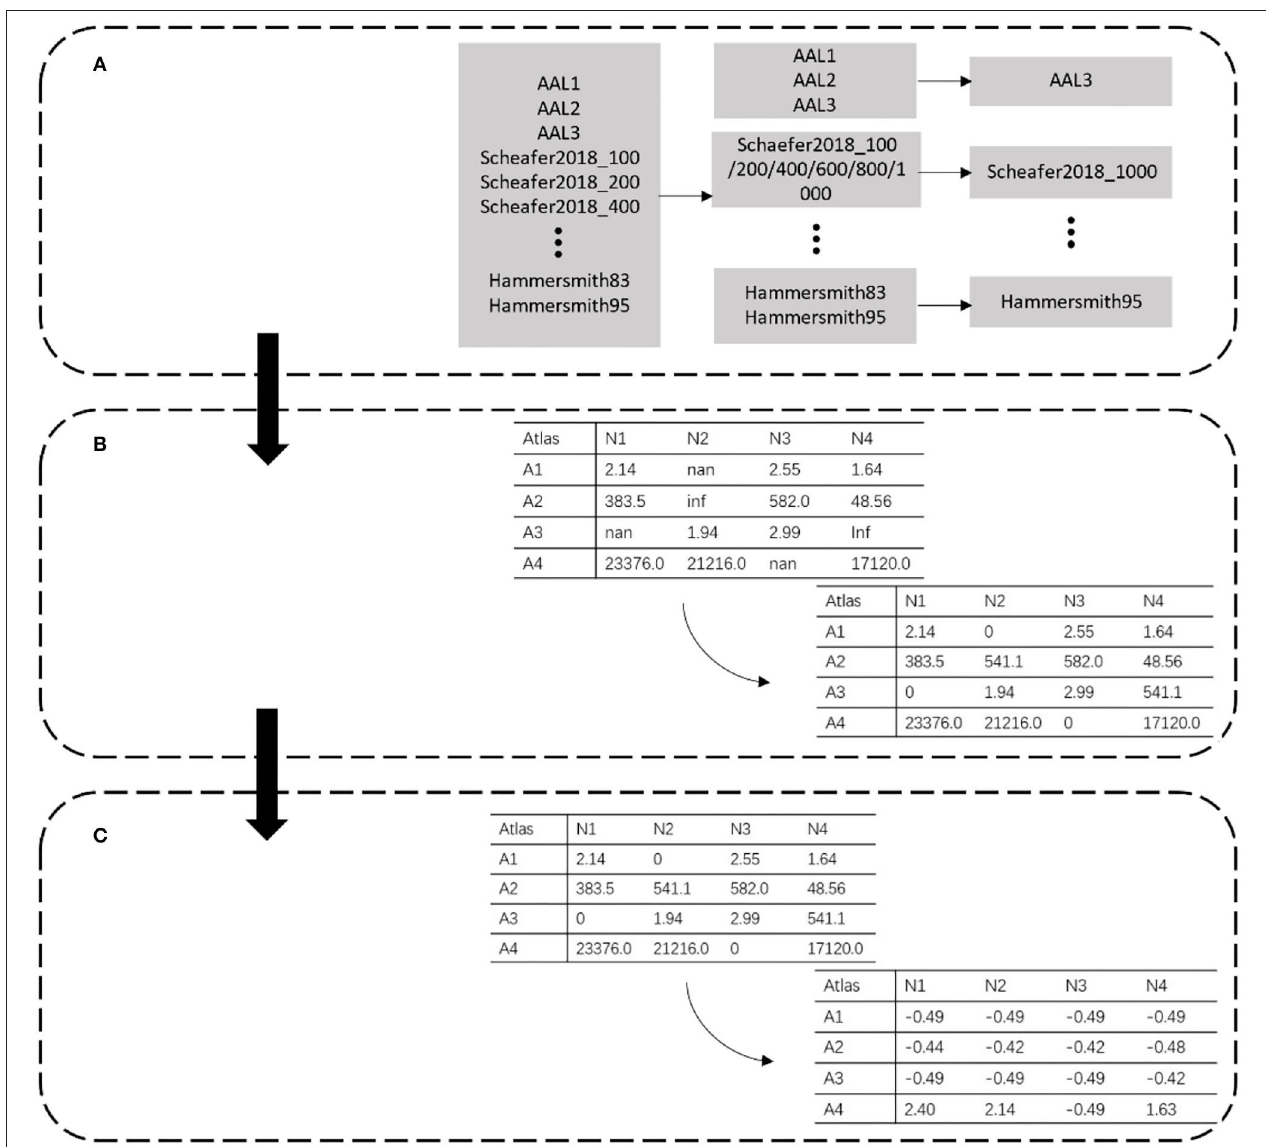
FIGURE 1 | Data preprocessing. Each row represents different partitions. Atlas is represented by A, and N in each column represents the extracted data number. (A) Atlas filtering. (B) Invalid value replacement. (C) Data